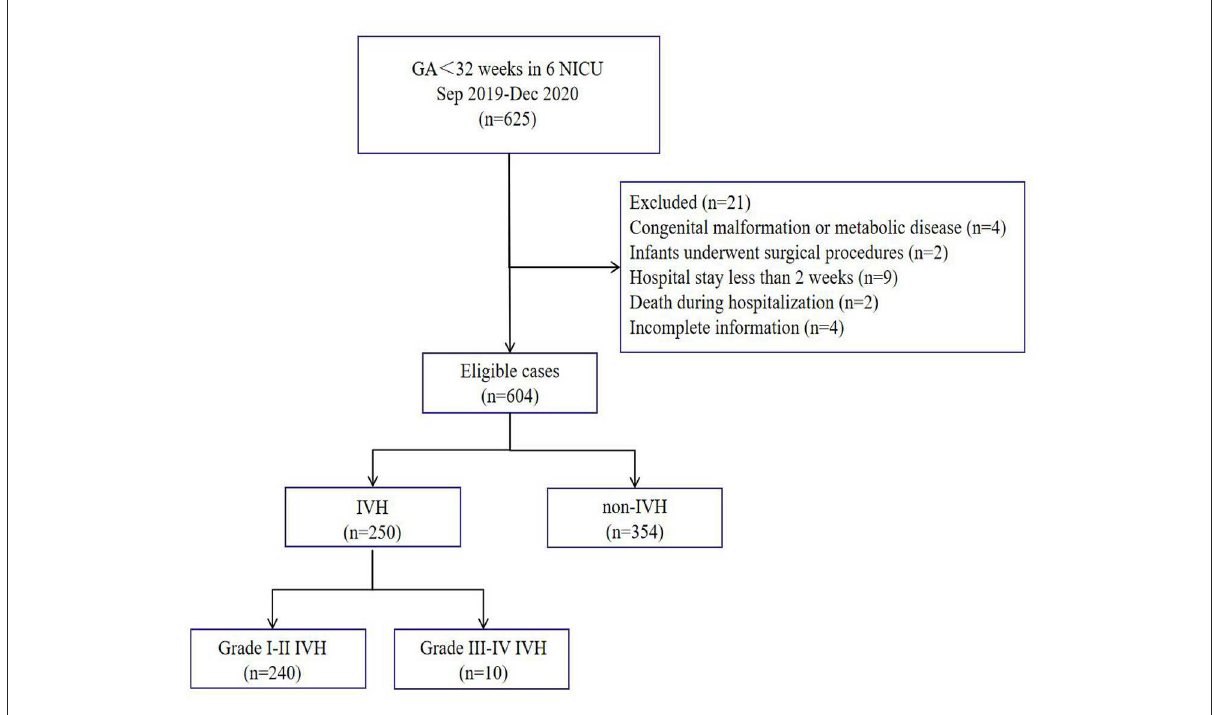
FIGURE1 Flow chart of participant selection and categorization in the study.